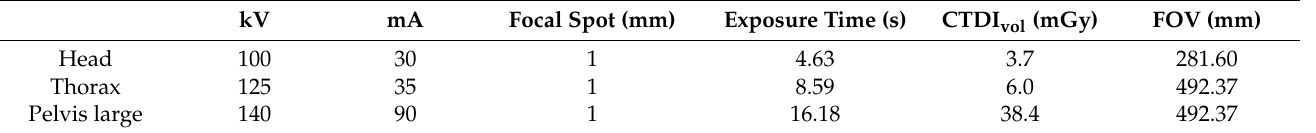
Table 1. Acquisition parameters used for each CBCT acquisition mode.